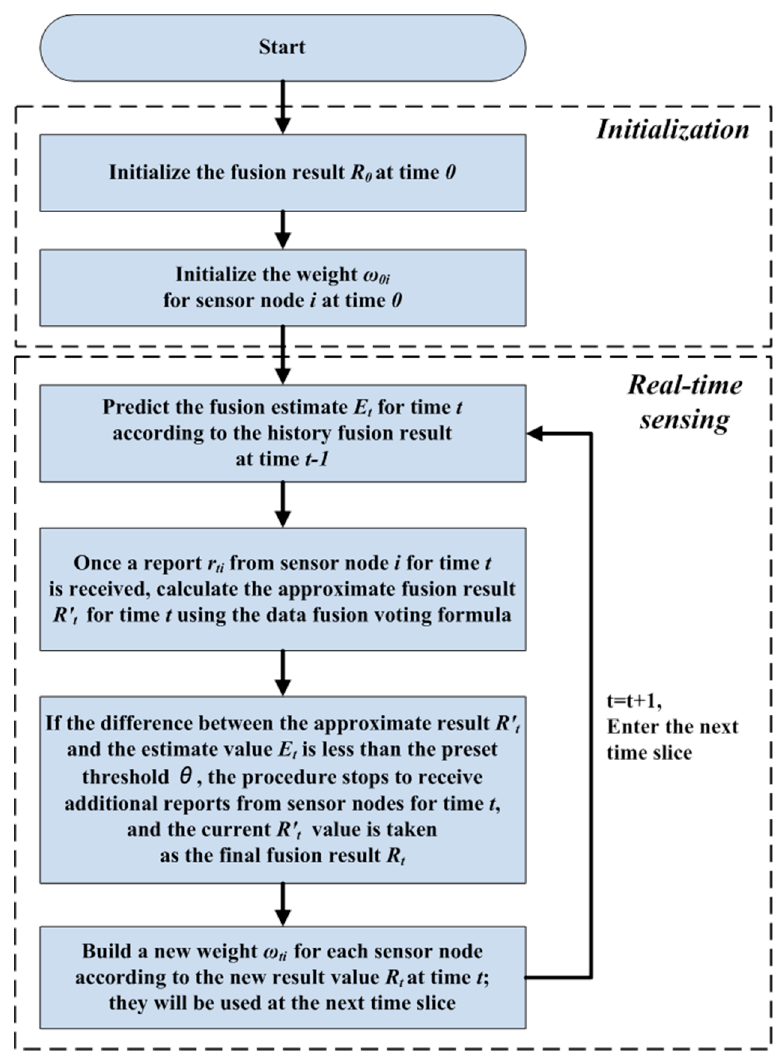
Figure 4. Procedure of the acceleration mechanism.